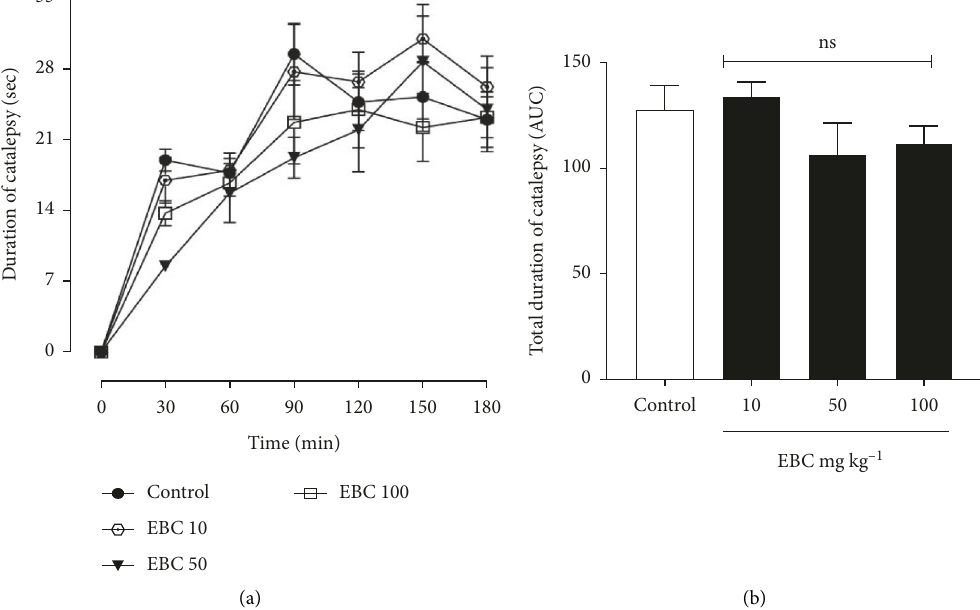
Figure 3: Bombax costatum extract inhibits haloperidol-induced catalepsy. Data are presented as mean duration of catalepsy. (b) Area under the curve (AUC) of the total duration of catalepsy.